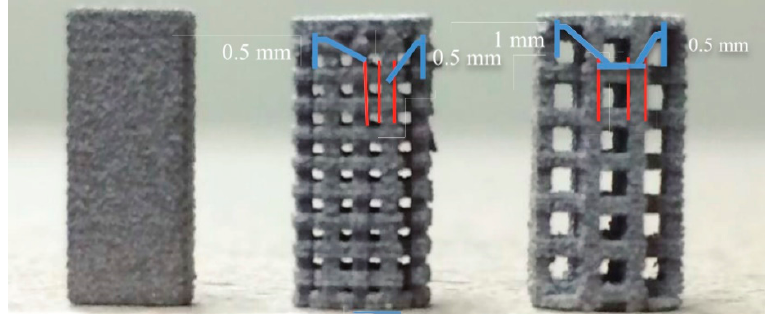
Figure 21. Solid, grid lattice of 1.0 mm, grid lattice of 1.5 mm structure [90]. Table 15. Young’s modulus and relative density for three different samples manufactured by BJ.